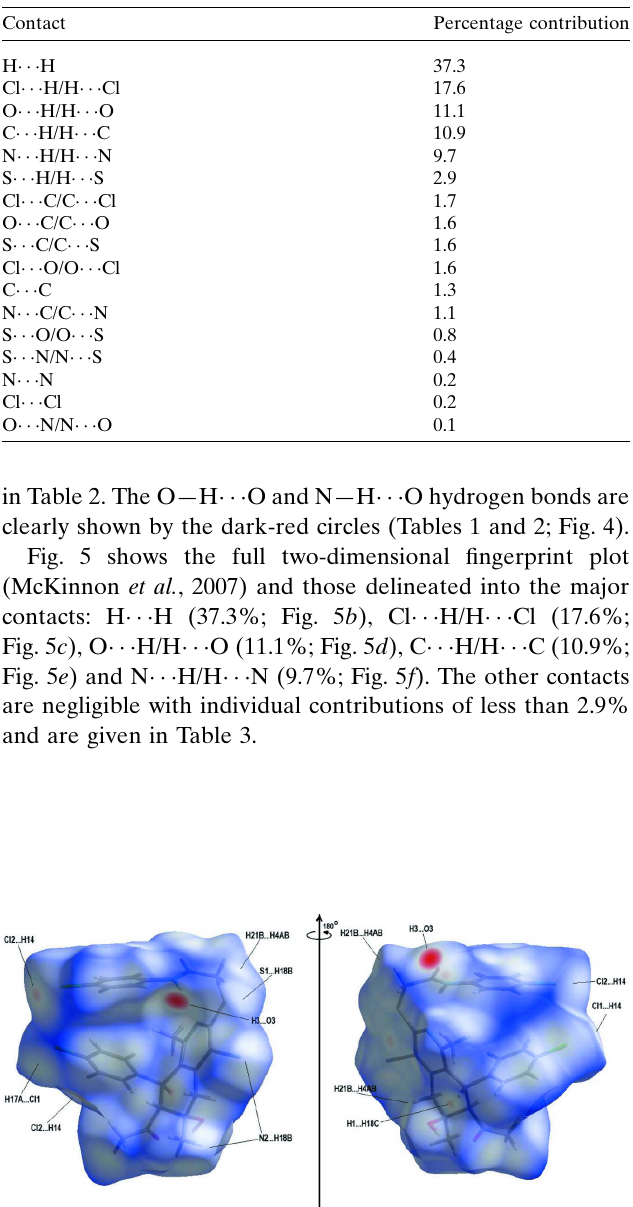
Table 3 Percentage contributions of interatomic contacts to the Hirshfeld surface for the title